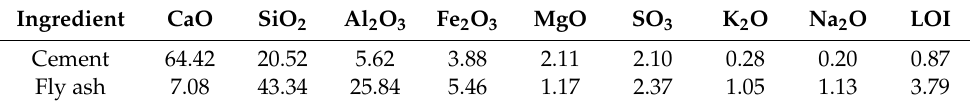
Table 1. Chemical compositions of the cement and fly ash used in this study (wt.%).